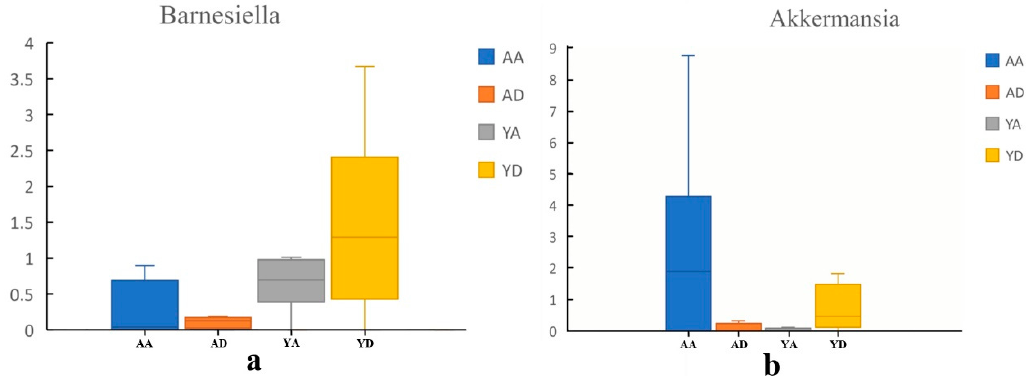
Figure 3. The gut bacterial composition of the volunteers. ( a ) The bar chart of the relative phylum abundance exceeding 1%; ( b ) The bar of the relative genus abundance exceeding 1%; ( c ) 21 d LefSe genus analysis; ( d ) The bar of the relative species abundance exceeding 1%.